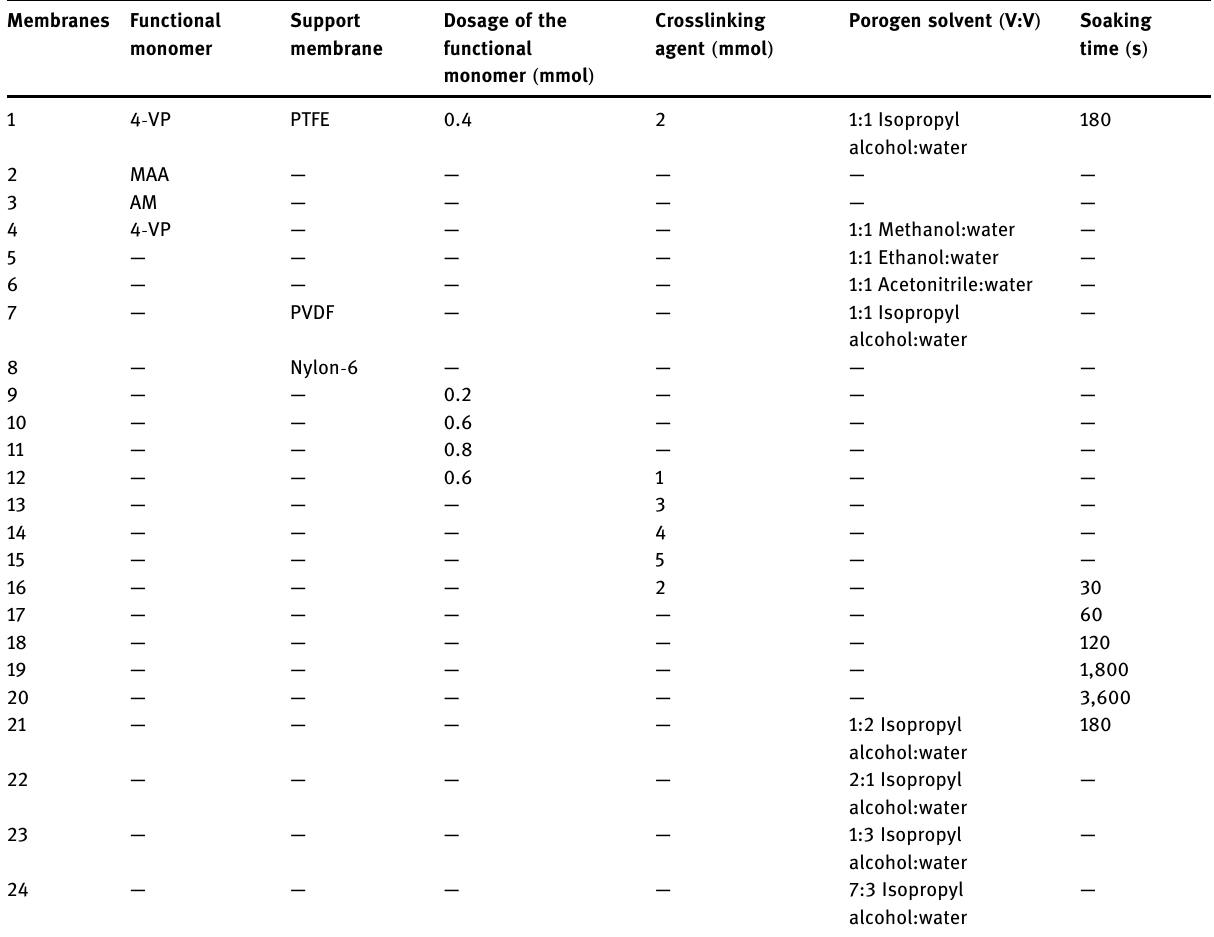
Table 1: Preparation of membranes Membranes Functional